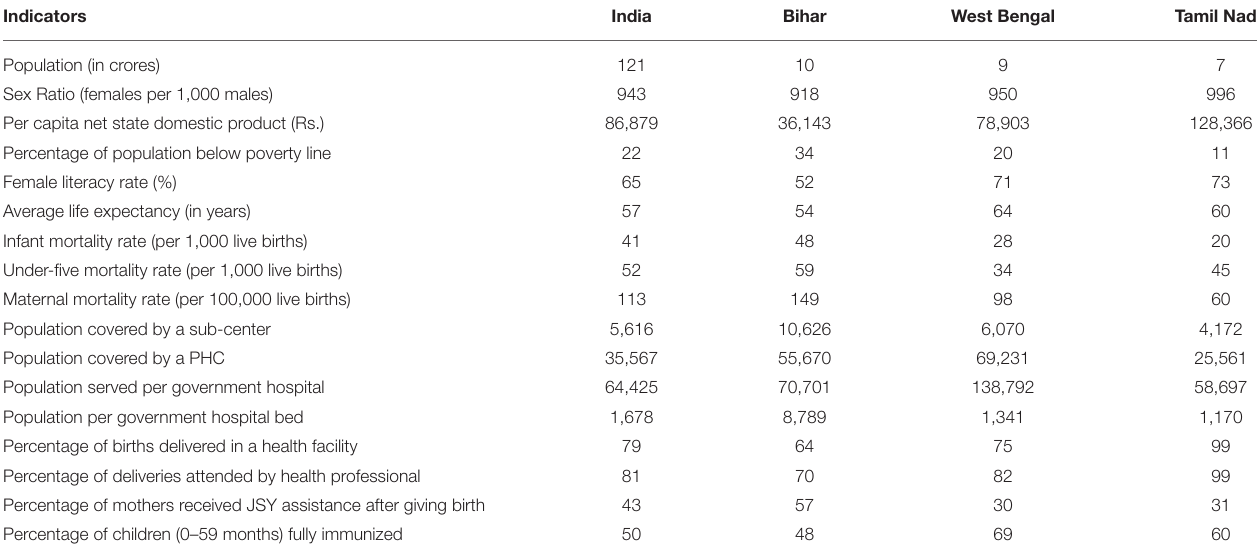
TABLE 1 | Selected socio-economic and health indicators of India, Bihar, West Bengal, and Tamil Nadu. Indicators India Bihar Population (in